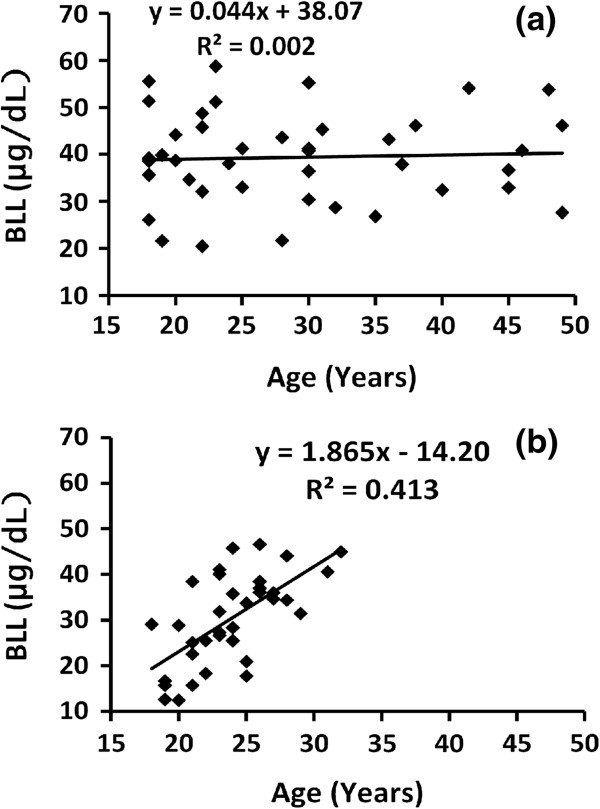
Age versus BLL of construction workers (a) and non-construction workers (b).